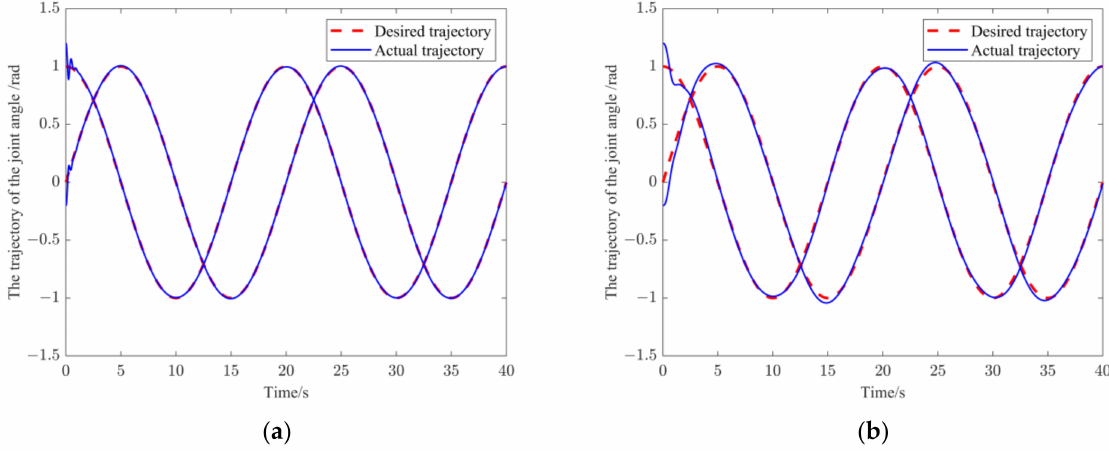
Figure 16. The trajectories of the joint angle q